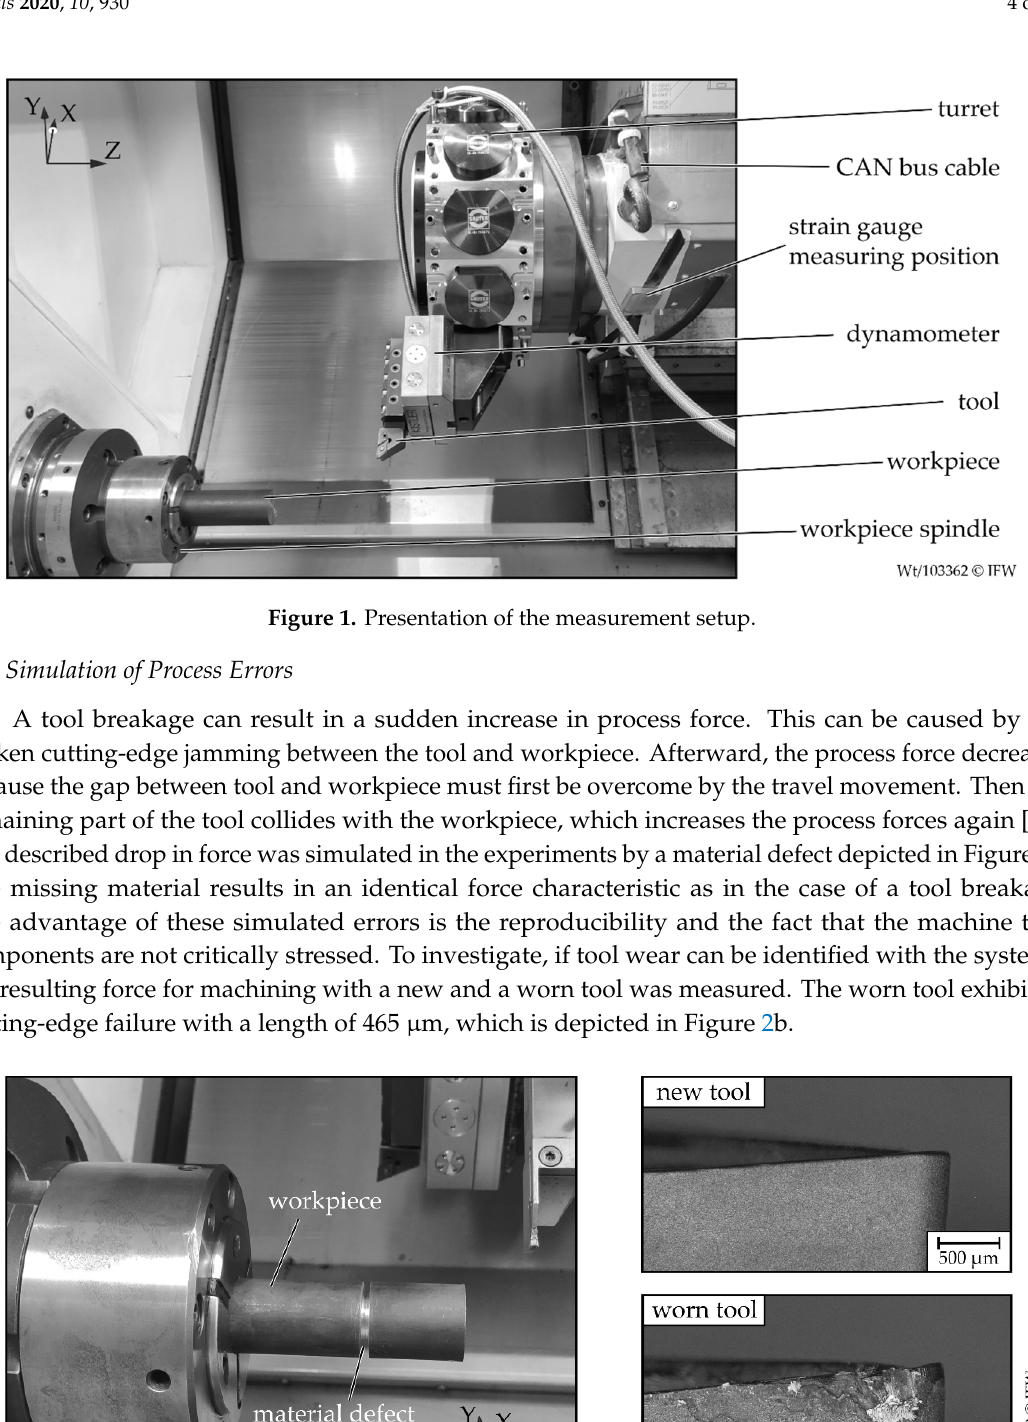
Table 1. Material properties. Material properties